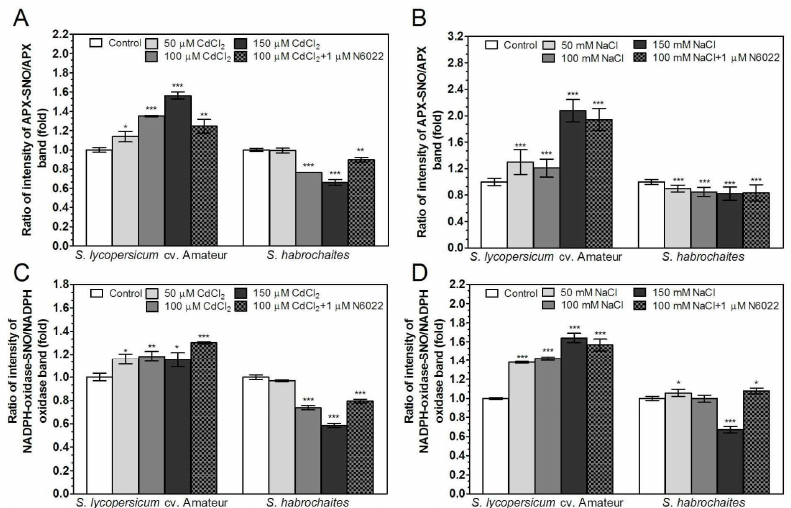
Figure 8. E ff ects of cadmium and salinity stress on S-nitrosation status of APX and NADPH oxidase in tomato roots. S-nitrosation status of ( A , B ) APX and ( C , D ) NADPH-oxidase in plant exposed to cadmium ( A , C ) or NaCl ( B , D ) was calculated as ratios of band intensities of S-nitrosated protein (APX-SNO and NADPH-oxidase-SNO, respectively) vs. band intensities of total APX or NADPH oxidase protein determined by Western blot method using ImageJ 1.33 software (Supplementary Figures S5 and S6). Values indicate relative changes of each immunoreactive band compared to the control plants, to which the value of 1 was assigned. The data are presented as means ± SD ( n ≥ 3). Significantly di ff erent means from the control values are denoted by asterisks (ANOVA, * p < 0.05, ** p < 0.01, *** p < 0.001).